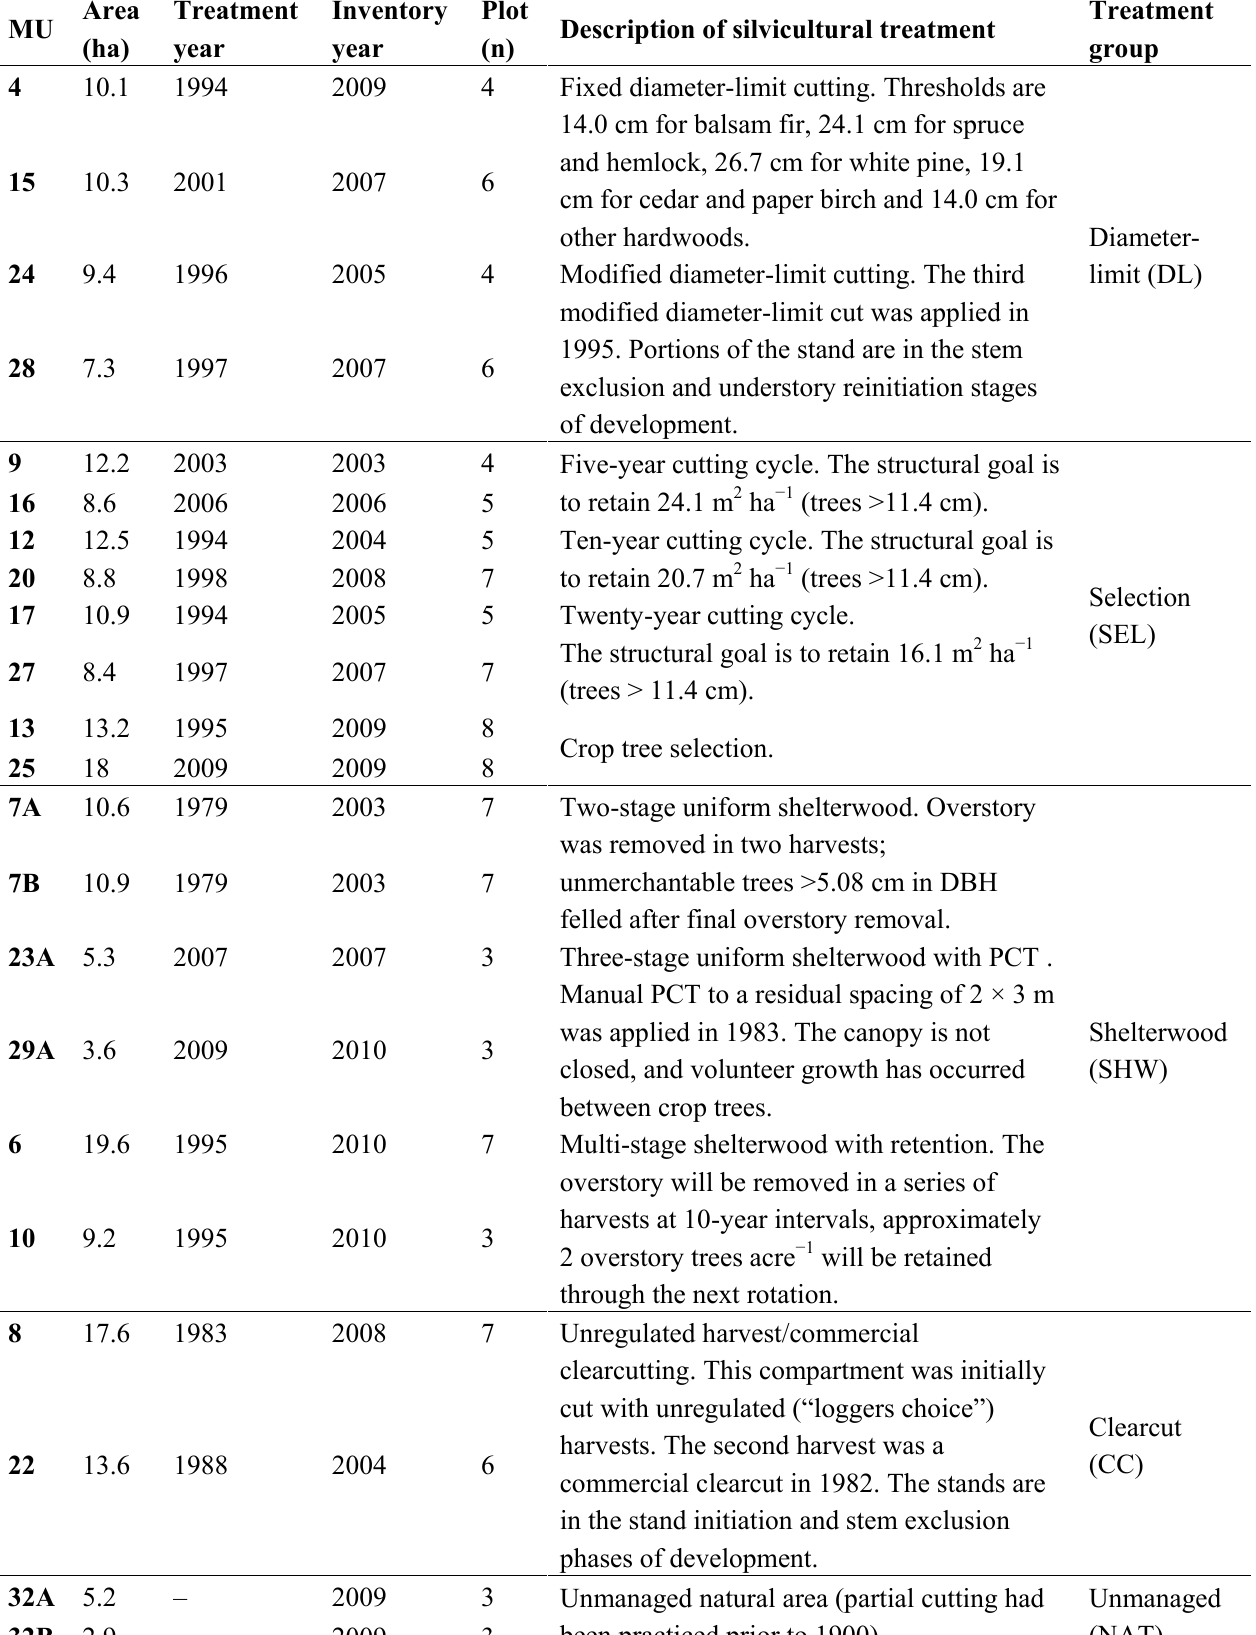
Table 1. Description of silvicultural treatments in management units (MUs) in the study area. DBH, diameter at breast